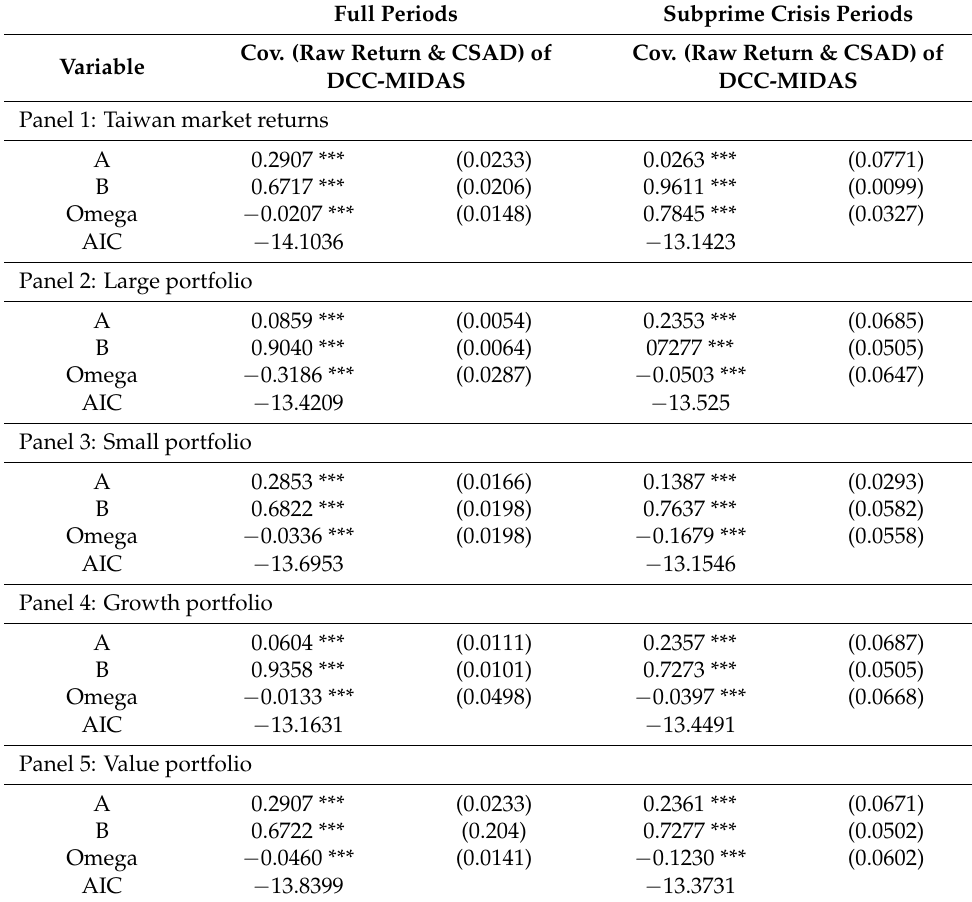
Table 3. Results of the maximum likelihood estimation of the DCC-MIDAS model between the CSAD and market returns during the full and subprime crisis